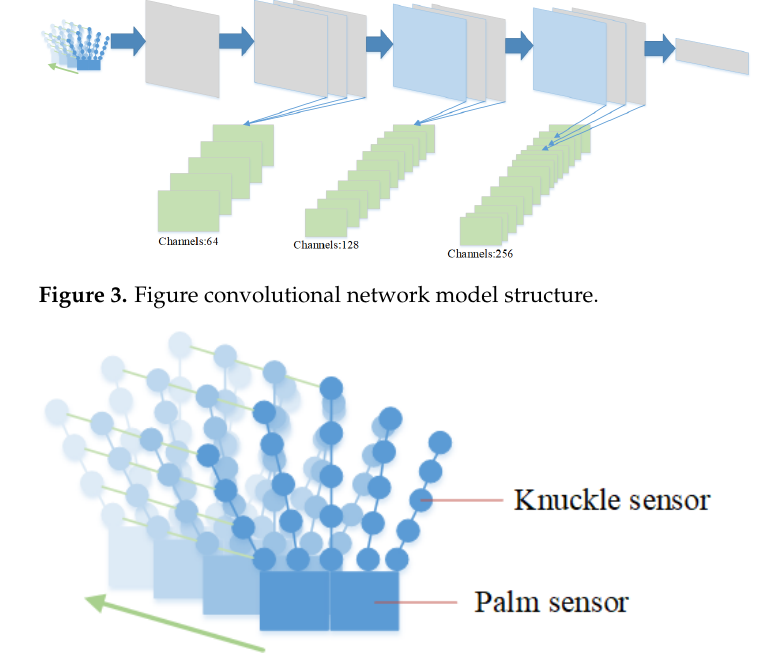
Figure 4. Hand actions vector